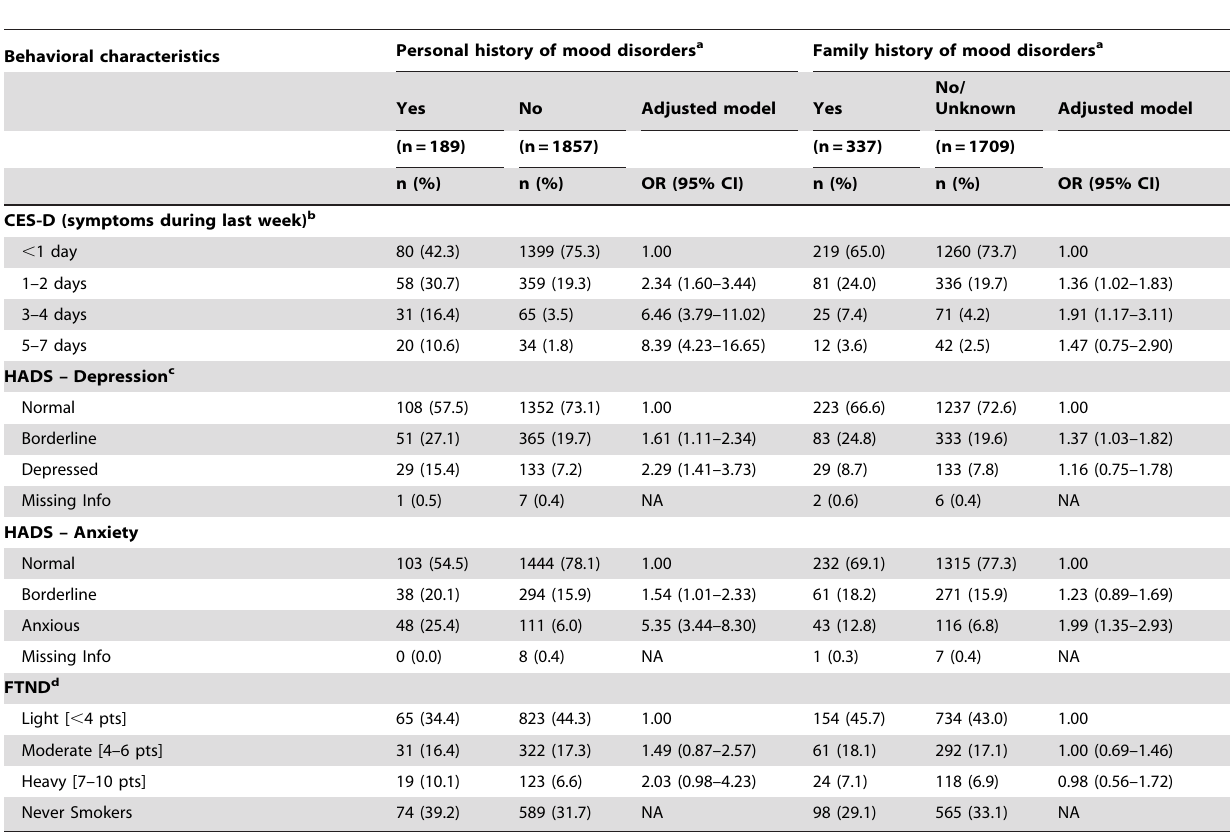
Table 3. Odds ratios (95% confidence intervals) of personal or family history of mood disorders among controls (n=2,046) by mood symptoms and measures of nicotine dependence, EAGLE Study, Italy,